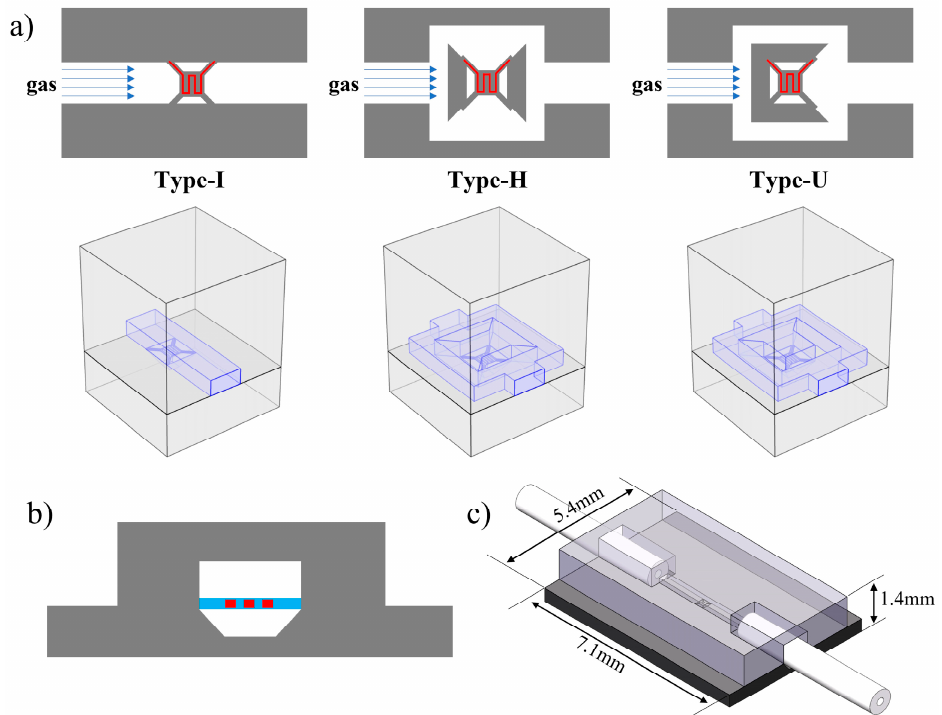
Figure 2. The schematic diagram of the designed structures: ( a ) Top view of different gas channel designs (Type-I, Type-H and Type-U) and the 3D models for simulation, ( b ) cross-section view of the TCD, ( c ) structure diagram of the designed TCD (take Type-I as an